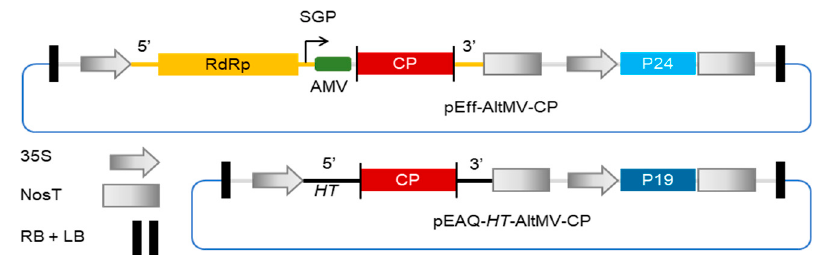
Figure 1. Schematic diagram of constructs used to express the AltMV CP. Both constructs have the same binary vector backbone (pEAQ, blue line) but differ in the way in which inserted coat protein (CP) sequence is expressed. Transcription from the 35S promoter of pEff results in the production of potato virus X (PVX) replicons, with expression of CP occurring via a subgenomic mRNA from the subgenomic promoter (SGP) on the PVX replicon. Translation is enhanced by the presence of the 5 ′ UTR from alfalfa mosaic virus (AMV) upstream of the CP and the P24 suppressor of gene silencing on the T-DNA. For pEAQ, transcription results in hyper-translatable ( HT ) mRNA with 5 ′ and 3 ′ UTRs from cowpea mosaic virus (CPMV) and expression levels are enhanced by the presence of the P19 silencing suppressor on the T-DNA.